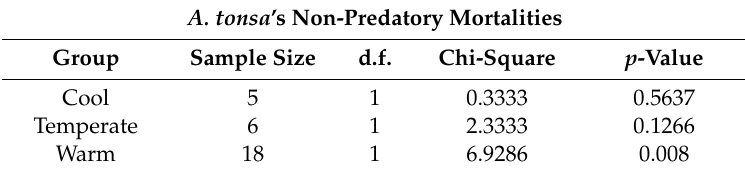
Table 5. The Kruskal-Wallis test on di ff erences in Acartia tonsa ’s non-predatory mortality between the more-oxygenated and less-oxygenated subgroups within the cool, temperate, and warm